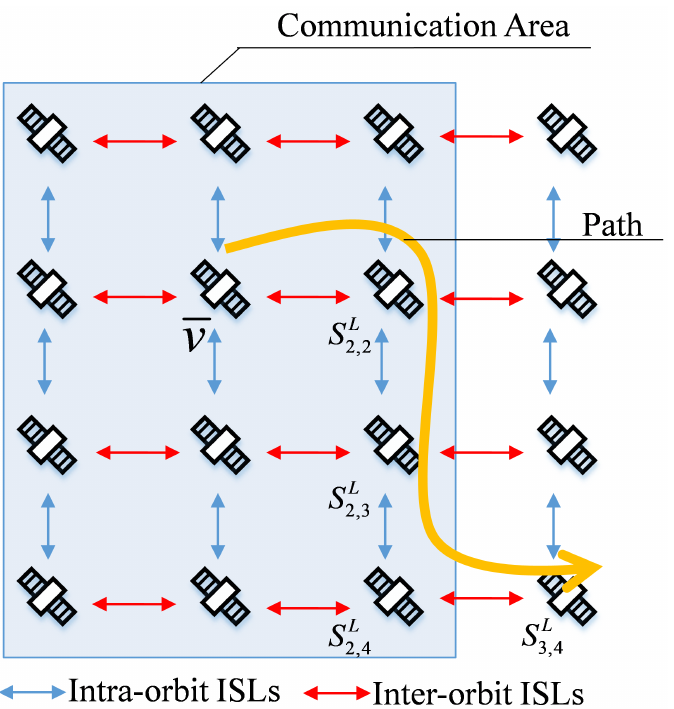
Figure 6. The relationship between packet transmission path and communication domain Equation